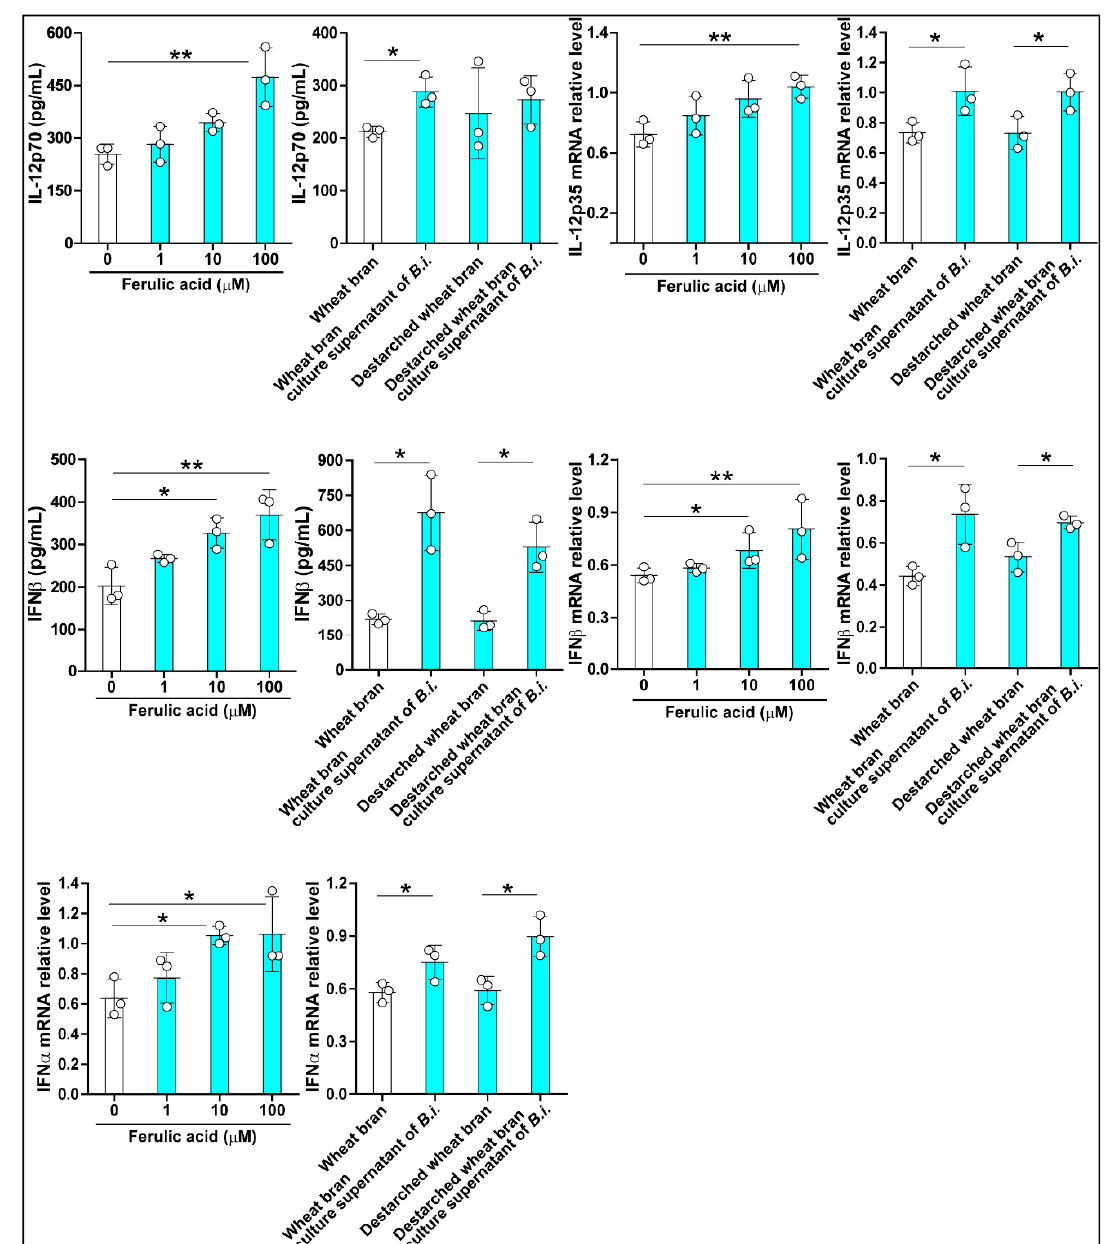
Figure 6. Bacteroides intestinalis culture supernatant modulated cytokine expression in HIEC-6 cells. Culture supernatant from Bacteroides intestinalis grown in wheat bran and de-starched wheat bran increased the expression of cytokines as demonstrated by RT-PCR and immunoassays. Ferulic acid in three different concentrations (1, 10, and 100 µM) was used as a positive control. N = 3 in each treatment group. Data are the mean ± S.D. Results from one representative experiment of two independent experiments are shown. Statistical analysis was performed using the Kruskal–Wallis analysis of variance with Dunn’s test and the Mann–Whitney U test. * p < 0.05, ** p < 0.01.